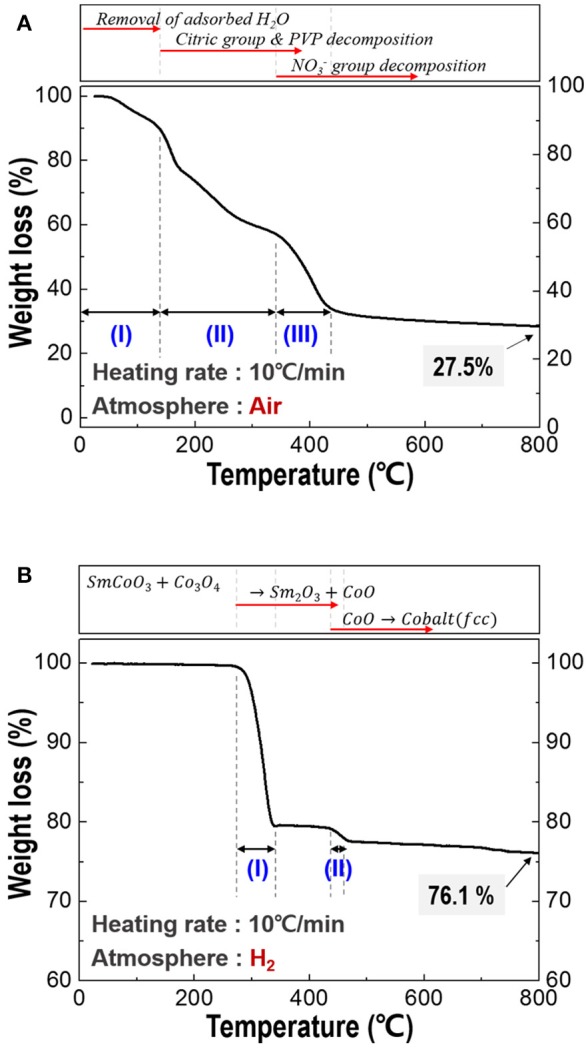
Thermogravimetric analysis (TGA) of the composite fiber; (A) spun fibers composed of PVP/Sm nitrate/Co nitrate/citric acid, and (B) calcined fiber which is made up of SmCoO3/Co3O4.